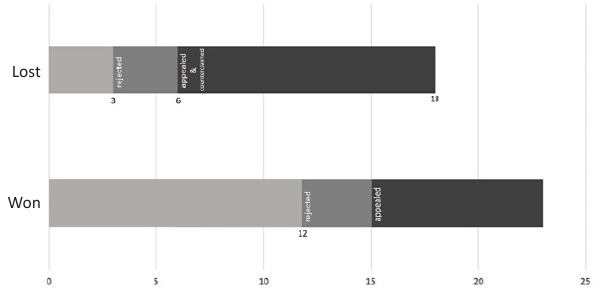
Figure 3. The legal proceedings of 41 noise cases from the litigants’ point of view